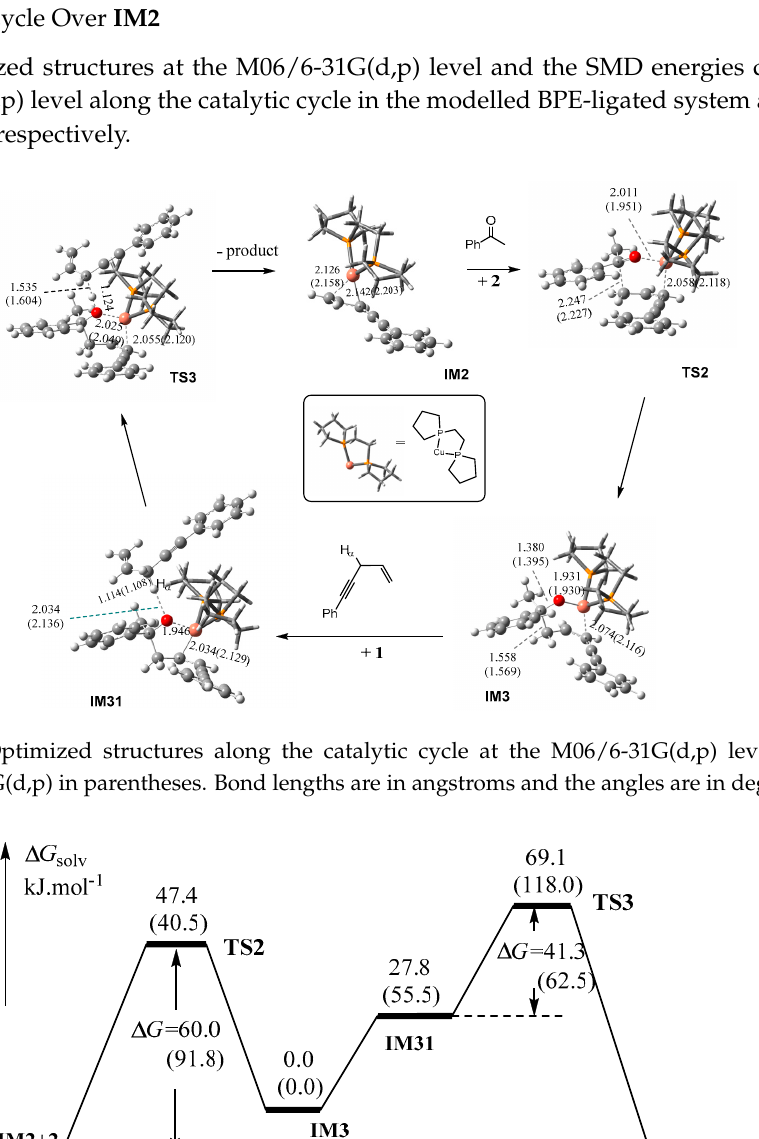
Figure 4. Evolution of energies along the reaction routes in the THF system. Δ G solv (in kJ mol -1 ) for various species are calculated at the M06(SMD, THF)/6-311+G(d,p) level; Δ G solv (in kJ mol -1 ) at the B3LYP(SMD, THF)/6-311+G(d,p) level are listed in parentheses.